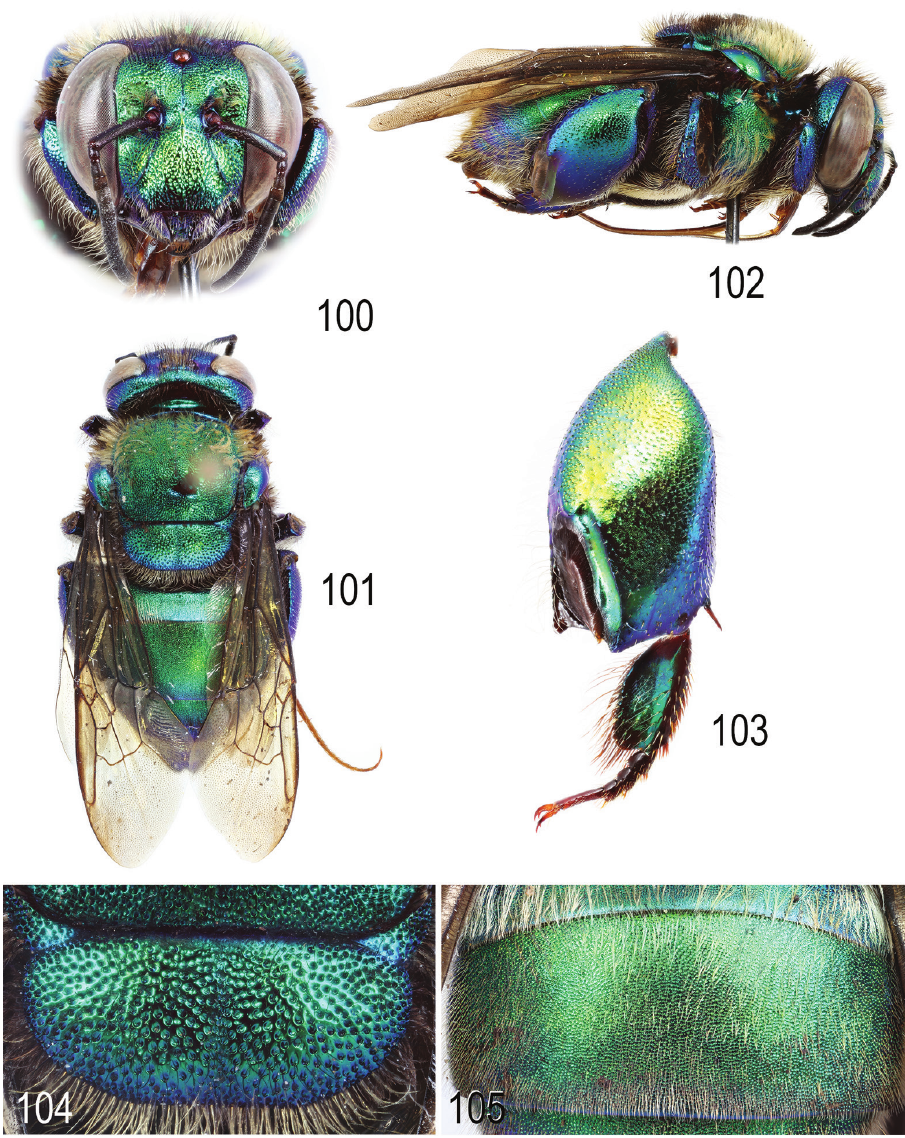
Figures 100–105. Male holotype of E. engeli (except paratype in Fig. 103, KUNHM-ENT 0504531). 100 Facial view 101 Dorsal habitus 102 Lateral habitus 103 Outer view of hind leg 104 Dorsal view of mesoscutellum 105 Second metasomal